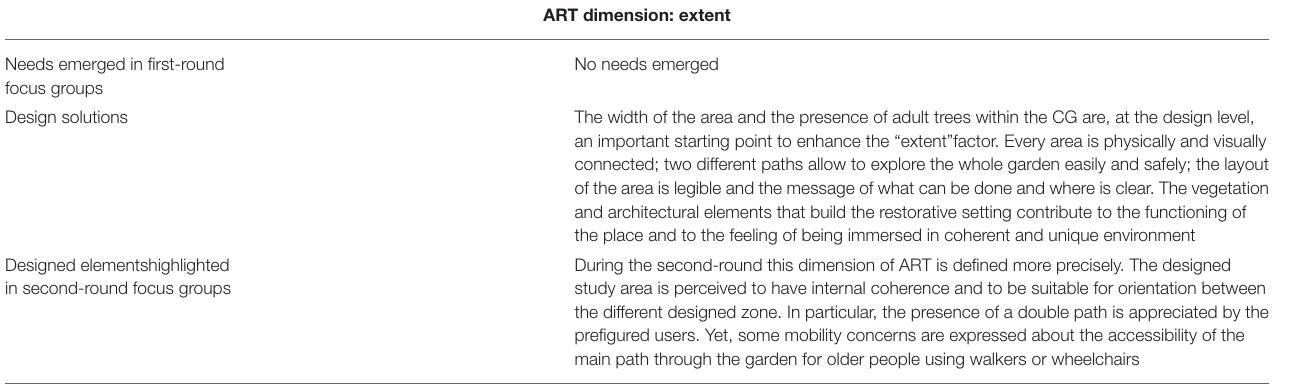
TABLE 5 | Comparison of the needs and reactions of the participants to the design proposal (ART, extent).